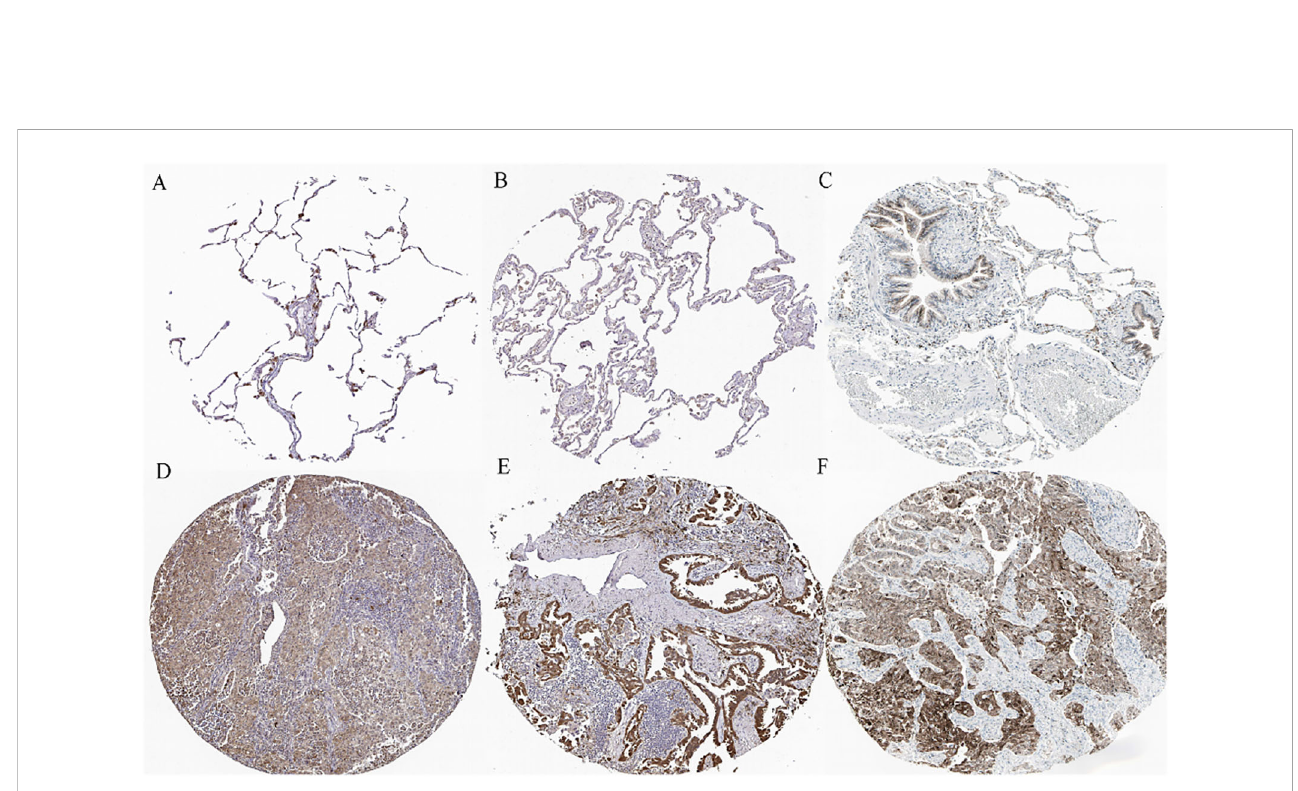
FIGURE 10 Representative immunohistochemical staining of TXN in (A – C) normal lung tissue and (D – F) lung cancer tissue